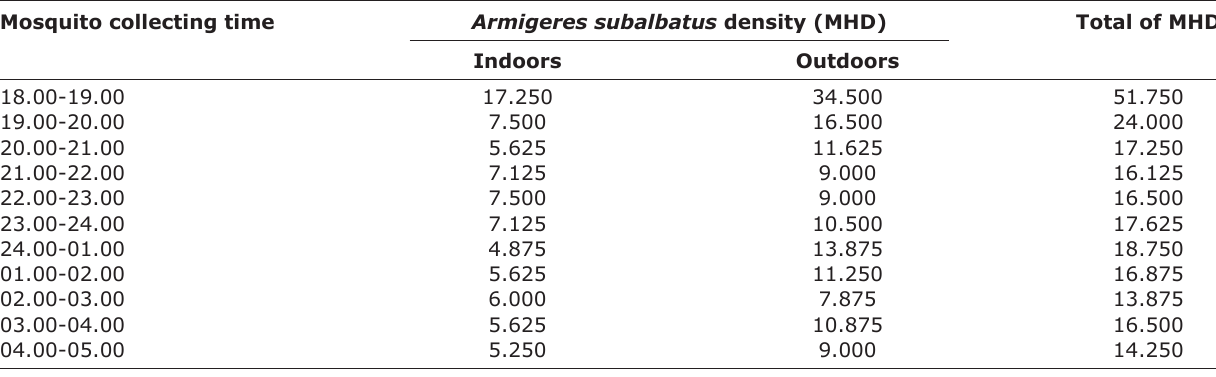
Table-3: The MHD of Ar. subalbatus from Lubuk Pauh village, July 2018. Mosquito collecting time Armigeres subalbatus density